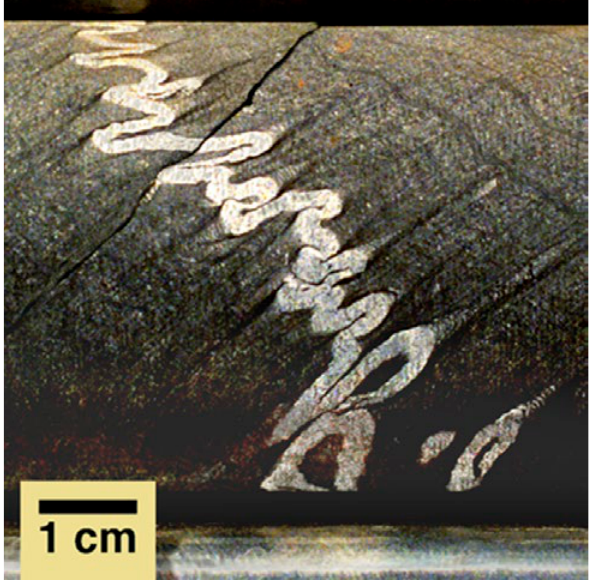
Figure 72. A ptygmatic quartz vein intrudes approximately parallel to the bedding in soft mobile dololutite. The ptygmatic loops have diffuse "tails" of quartz extending from them into the de-watering cleavage indicating that the vein was emplaced in the soft sediment before compaction and de-watering was completed. Woodcutters Mine, east of Batchelor, Northern